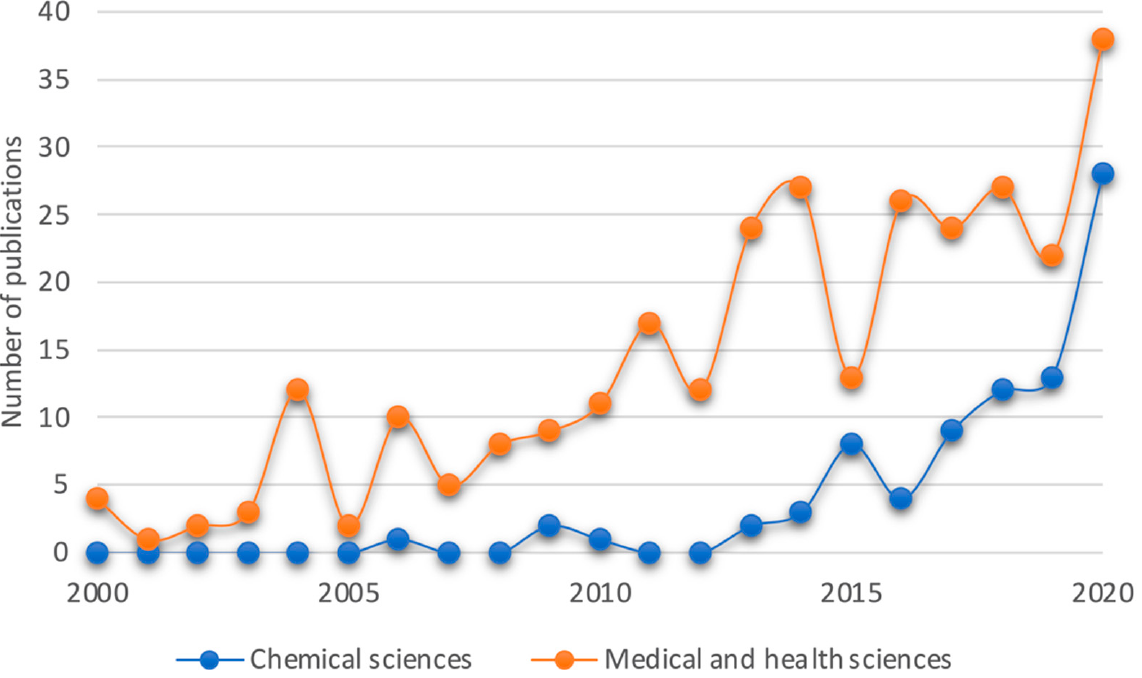
Figure 3. Publications containing the word Tragia since the year 2000 in Medical and Health sciences and in Chemical sciences. Data source: [18].